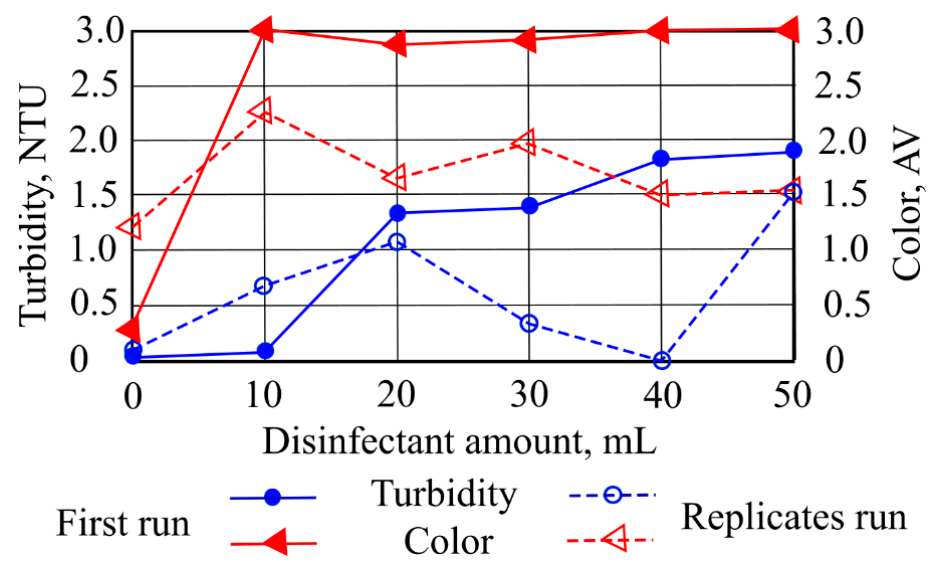
Figure 6. The impact of disinfectants on turbidity and color intensity.